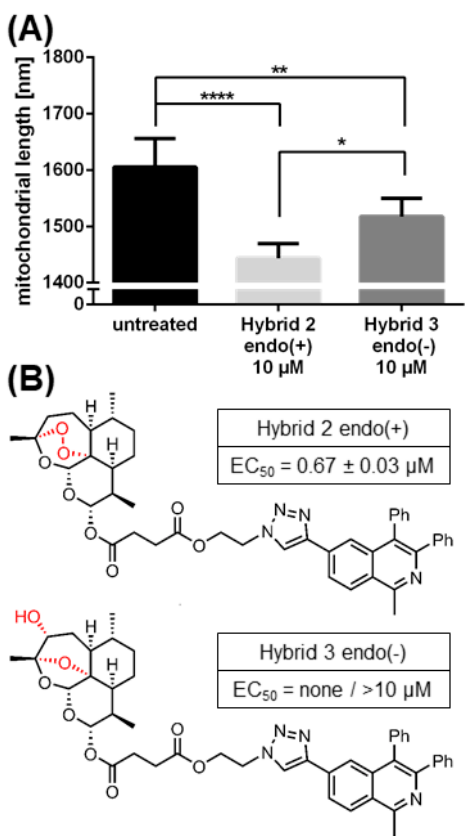
Figure 8. Conversion of mitochondrial architecture by BG95-related trioxane compounds is largely dependent on their endoperoxide bridge. HFFs were treated with the indicated concentrations of compounds or remained untreated for 3 d, after which they were fixed and stained. Staining procedure and assessment of mean mitochondrial length was performed as described for Figure 5. ( A ) Both Hybrid 2 endo( + ) and Hybrid 3 endo( − ) led to a decrease in mean mitochondrial length, with the endoperoxide bridge-intact Hybrid 2 changing mitochondria to a significantly higher degree than the endoperoxide bridge-negative Hybrid 3. Mean mitochondrial length was measured in at least 5 individual pictures and > 100 cells per compound. Data are given as the mean of mitochondrial length + SD. Statistical analysis was performed using ordinary One-way ANOVA followed by post-hoc Tukey’s test compared to untreated. **** p < 0.0001; ** p < 0.01; * p < 0.05 ( B ) Chemical structures and anti-HCMV e ffi cacy of ART derivatives Hybrid 2 endo( + ) and Hybrid 3 endo( − ), with the presence or absence of an endoperoxide bridge highlighted in